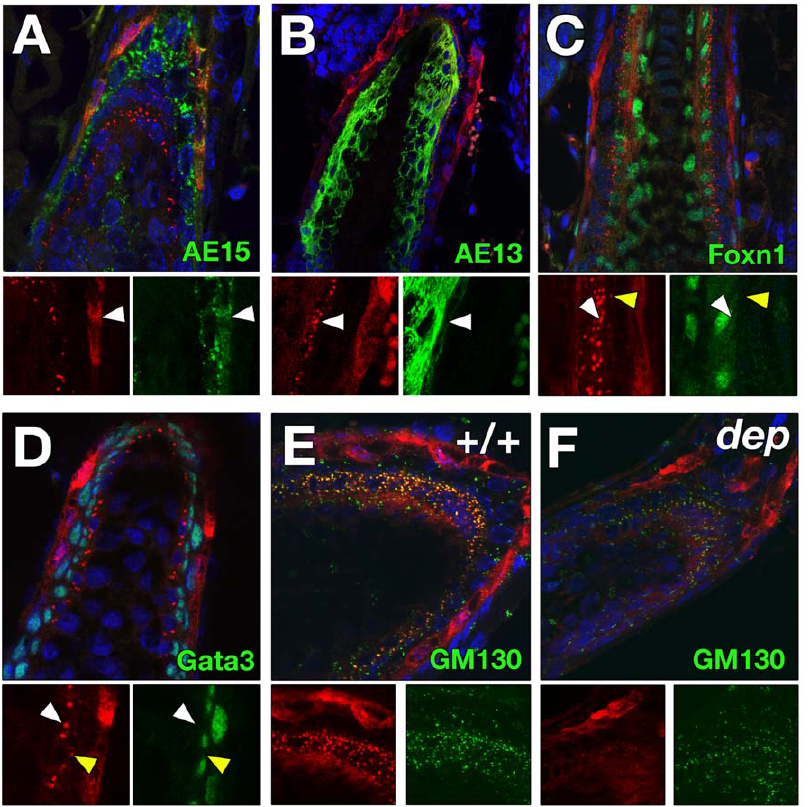
Figure 3. Zdhhc21 expression is restricted to differentiated post-mitotic lineages of hair follicles. Confocal slices (1 m m) of Zdhhc21 protein expression in wild type (A–E) and dep (F) P28 anagen follicles. (A) Ubiquitous Zdhhc21 (red) expression colocalizes with the outermost layer of AE15 (green) expression. (B) Punctate Zdhhc21 staining (red) colocalizes with the outermost layer of AE13 expression (green: weaker than inner cortex expression) and (C) Foxn1 expression (white arrowhead). (D) Single foci of Zdhhc21 staining (red: yellow arrowhead) per cell of the IRS cuticle is seen in the innermost Gata3-positive layer (green). (E) In wild type skin, punctae of Zdhhc21 (red) colocalize with GM130 (green), whilst diffuse staining is observed in dep mutants (F). Arrowheads mark same region in single channels.